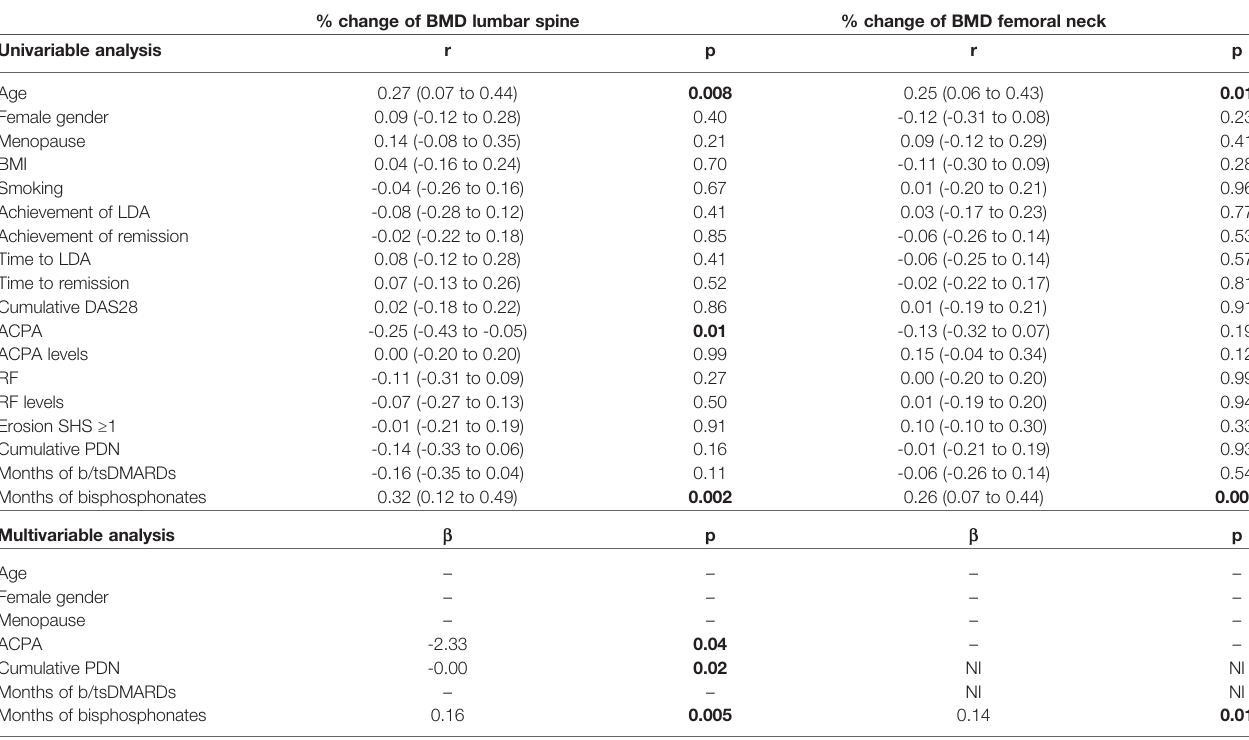
TABLE 3 | Predictors of BMD